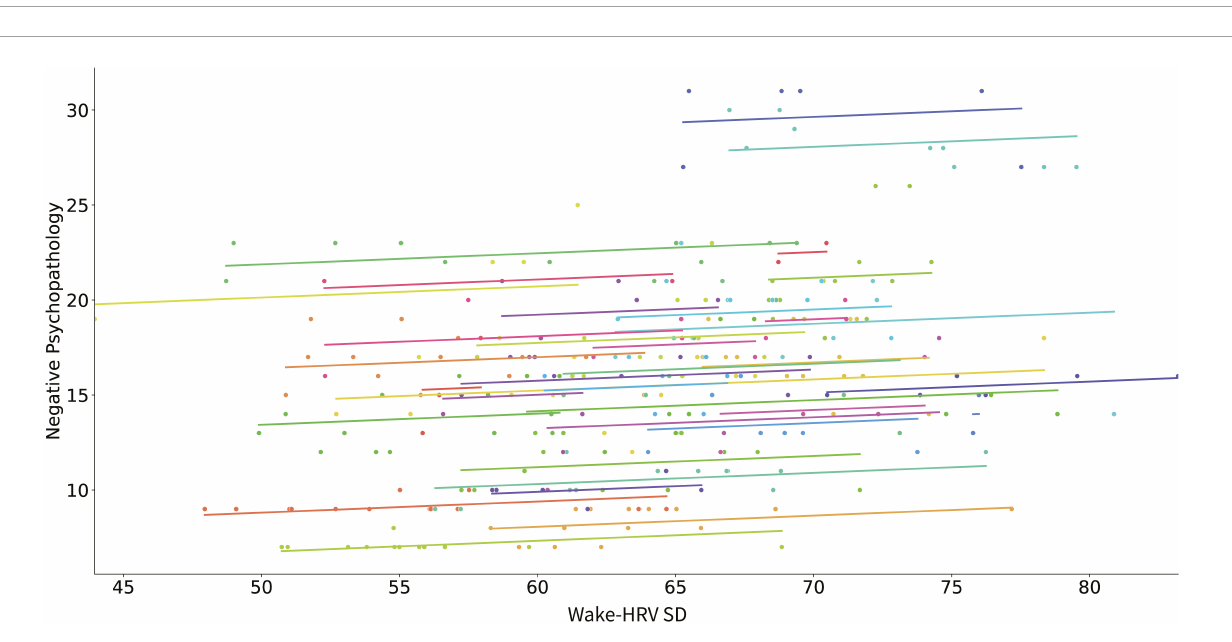
FIGURE4 Scatter plot of the relation of the SD of HRV during wakefulness and negative psychopathology (negative PANSS score). Each subject’s data as well as the predicted linear model line are presented with a different color.